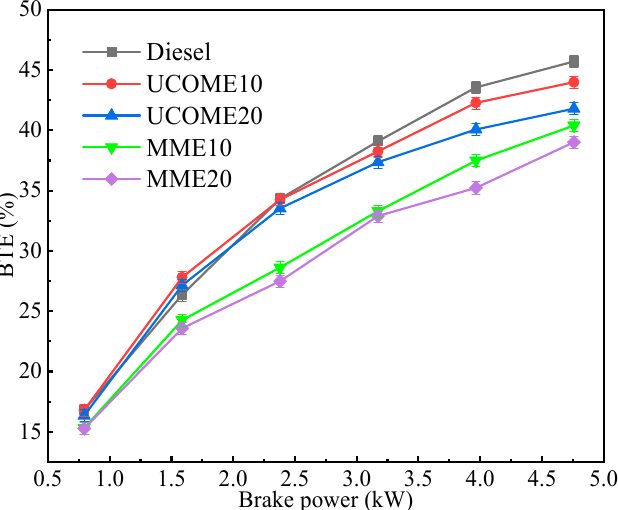
Figure 14. BTE comparison of mustard oil used cooking oil and diesel under different loads [173].